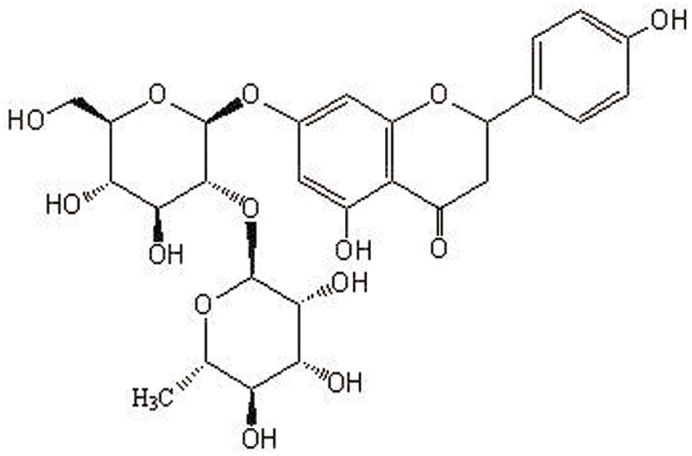
The chemical structure of naringin.The molecular formula of naringin is C27H32O14 and the molecular weight is 580.53.